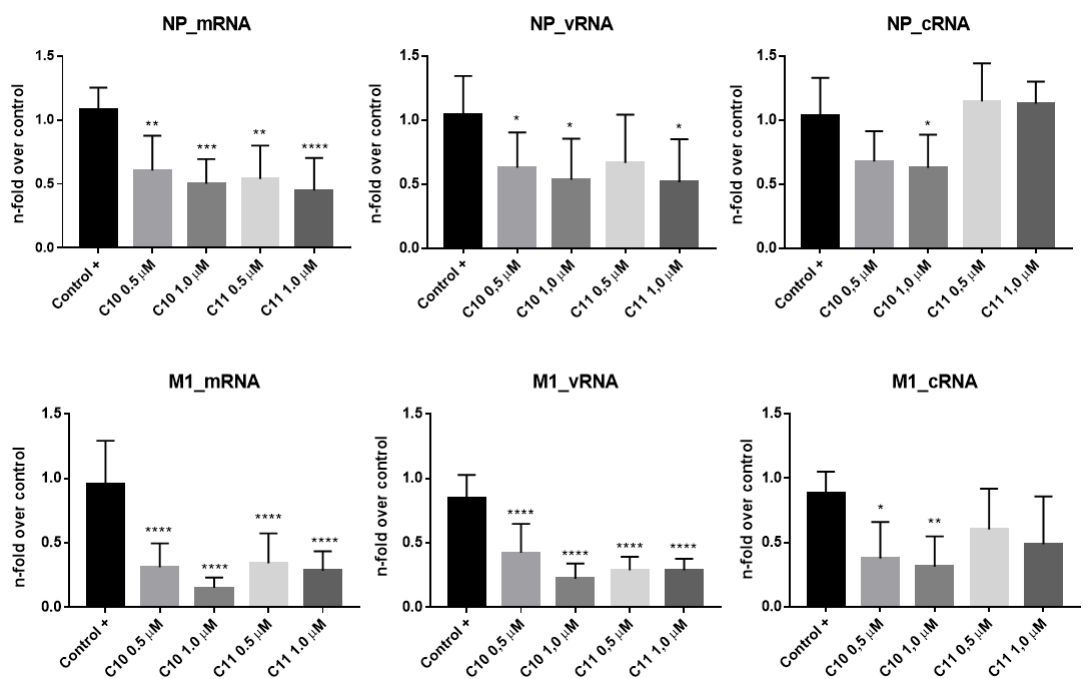
Figure 4. Effects of C10 and C11 on influenza A virus RNA transcription (strain A/WSN/33 (H1N1)). MDCK cells were infected at MOI 5 and then treated with both compounds (0.5 and 1.0 µM) for 6 h. Total RNA was extracted and viral mRNA, vRNA, and cRNA of NP (segment 5) and M1 (segment 7) were analyzed by qRT-PCR using glyceraldehyde 3-phosphate dehydrogenase (GAPDH) as the housekeeping gene. MDCK cells infected and just DMSO-treated (solvent control) were used as positive control (+). * p < 0.05; ** p < 0.01, *** p < 0.001 and **** p < 0.0001 vs. the respective viral controls, one-way ANOVA, post-hoc test Dunnet.